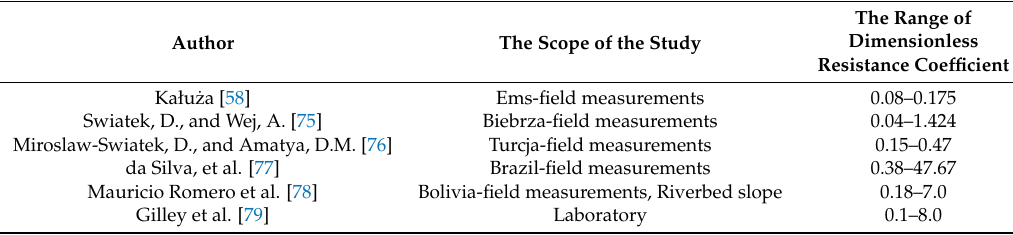
Table 3. Summary of resistance coefficients based on literature.